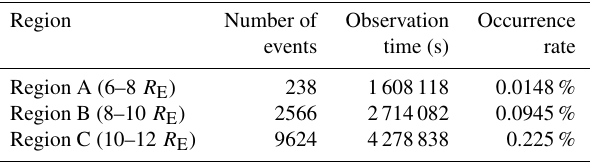
Table 2. Occurrence rate ( R > 0 .